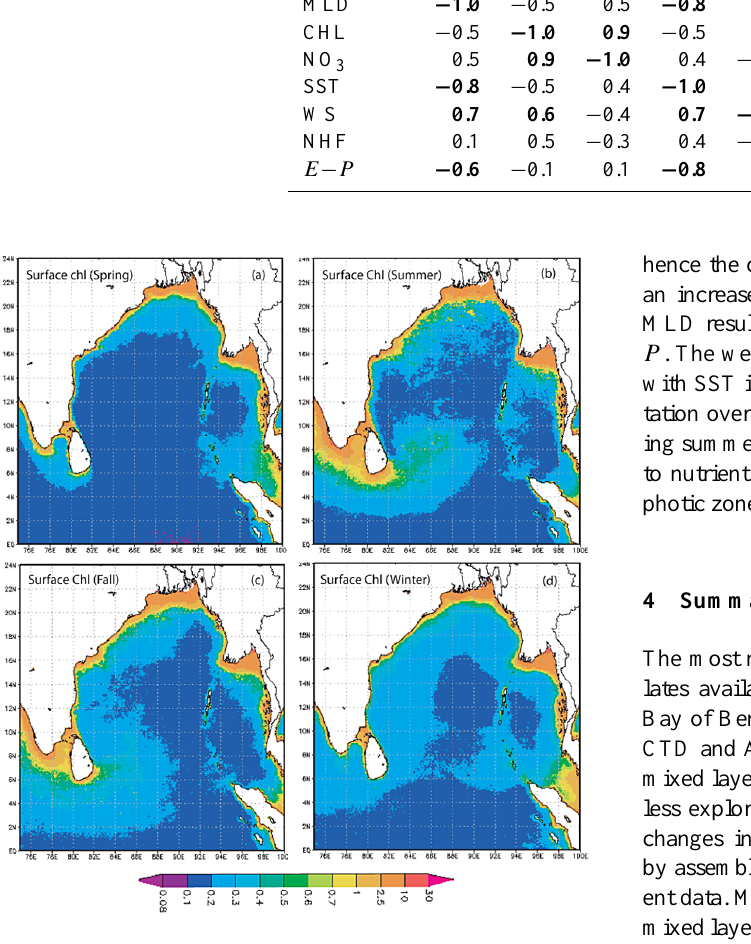
Figure 16. Satellite-derived surface chlorophyll pigment concen- trations (mgm − 3 ) in the Bay of Bengal during (a) spring intermon- soon, (b) summer, (c) fall intermonsoon and (d) winter